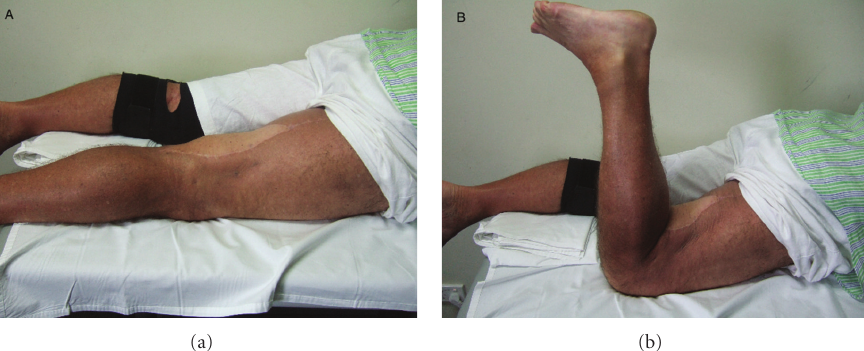
Figure 3: Patient treated for liposarcoma of the posterior thigh with wide resection involving hamstrings, reconstructed with innervated latissimus dorsi flap. Clinical outcome at 14 months post-op. (a) Full extension. (b) Active flexion. Muscle strength of posterior compartment of the thigh: 4.